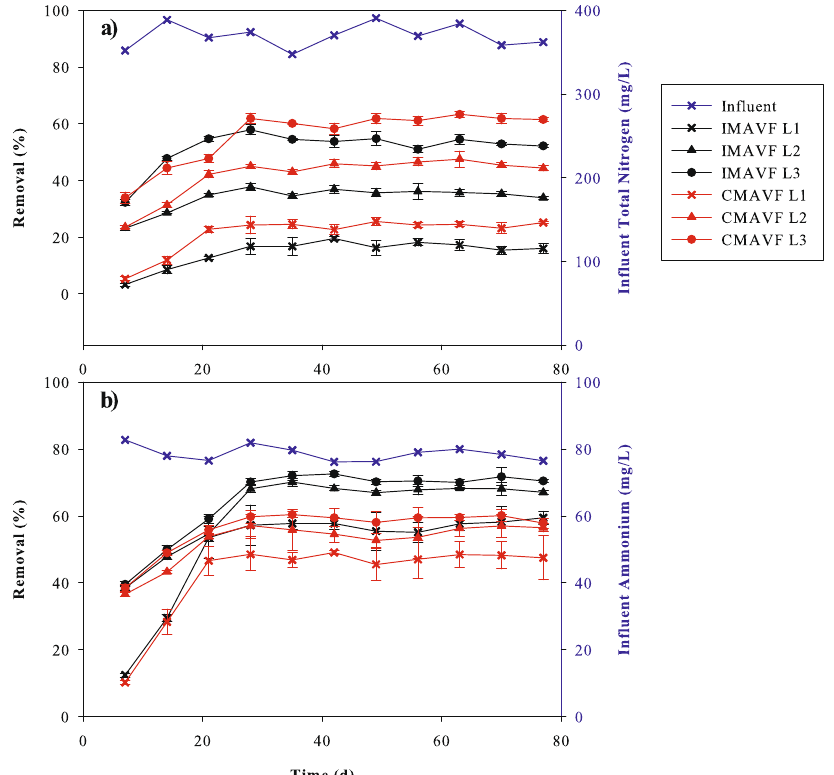
Fig. 2 Intermittent feeding, Total Nitrogen, and Ammonium. Effect of intermittent feeding on ( a ) TN and ( b ) NH 4 removal. IMAVF Intermittently fed macrophyte assisted vermi fi ltration, CMAVF Continuously fed macrophyte assisted vermi fi ltration. Error bars: standard deviation created using replicated ( n = 3) set-ups for each experimental condition]. Three layers placed at 0 – 30 cm (L3), 30 – 60 cm (L2), and 60 – 100 cm (L1) from the bottom, containing gravel, alum, and soil mix,